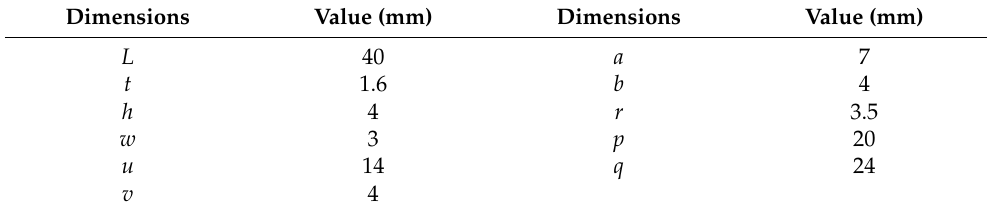
Figure 1. Layout of the proposed dual CP MIMO antenna: ( a ) top view; ( b ) side view; and ( c ) fabri- cated prototype. Table 1. Design particulars of the dual CP MIMO